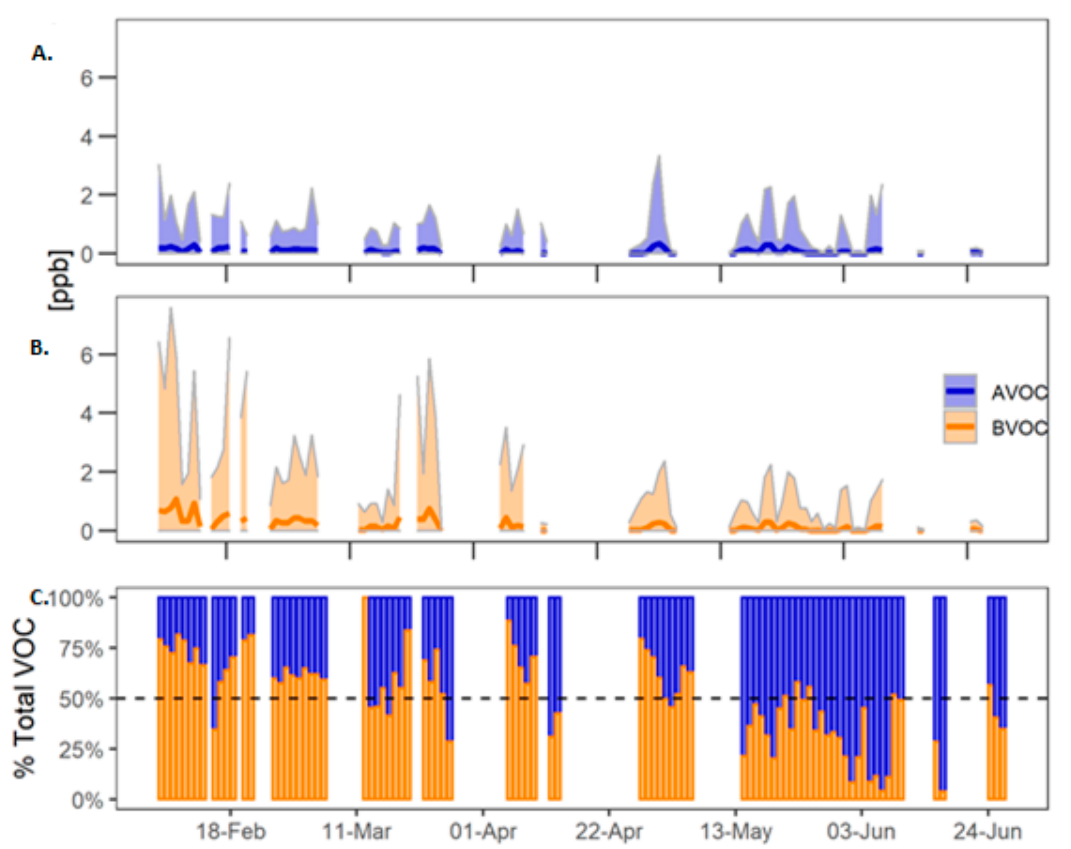
Figure 5. Total AVOC and BVOC during COALA-JOEYS. ( A ) Sum of the concentration of benzene, toluene and p-xylene; ( B ) Sum of isoprene, MVK, MACR, eucalyptol, p-cymene and α -pinene. The dark line shows the mean value and the area around the line shows the daily minimum and maximum values. ( C ) Ratio of biogenic and anthropogenic VOCs to the total VOC load excluding TMB.